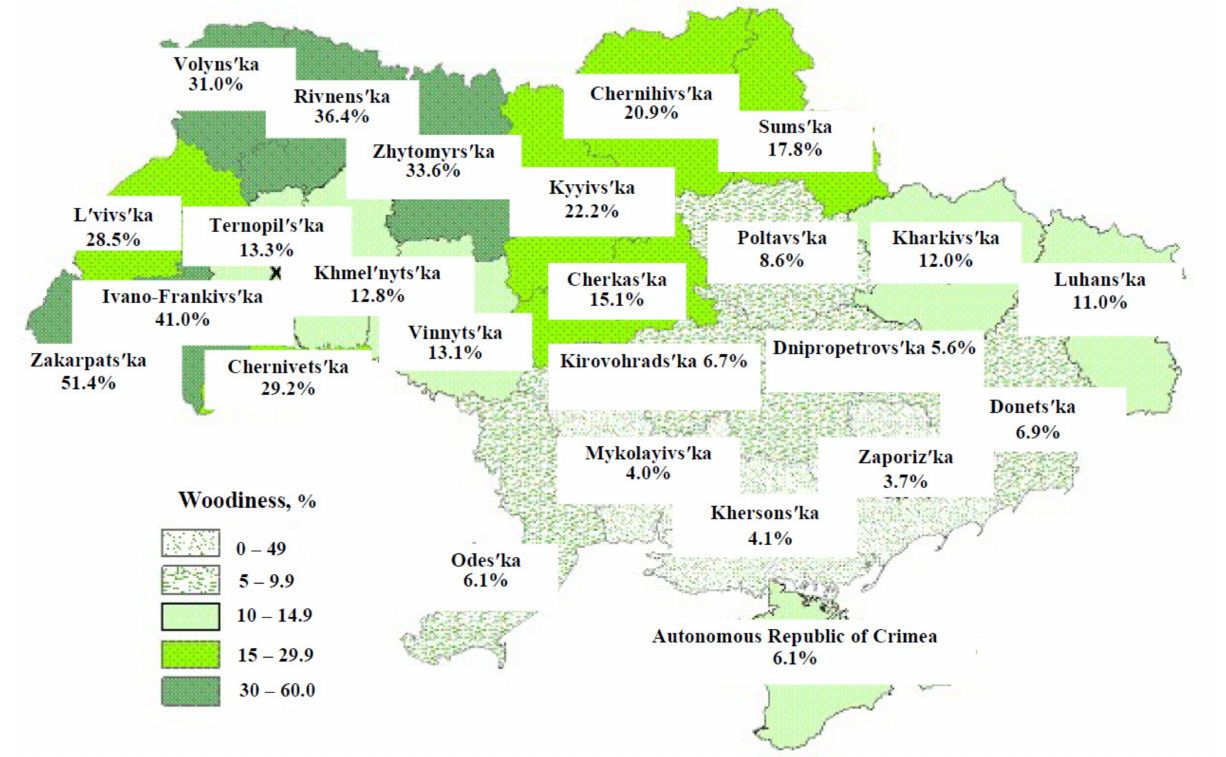
Figure 1. Raw material base for wood biomass provision in the territory of Ukraine